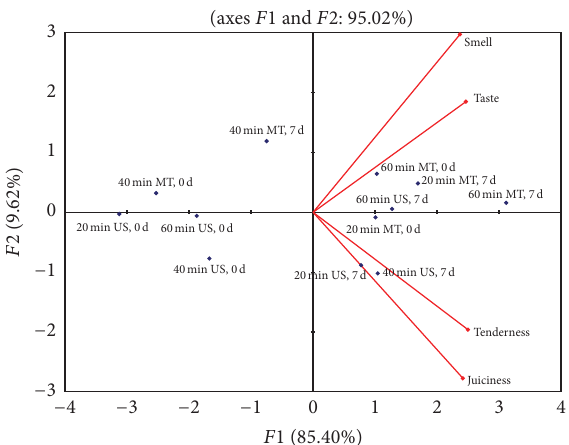
Figure 4: Sensory space of beef samples (longissimus dorsi) using two types of marination processes. MT, marinated traditionally; US, ultrasound; d, storage days at 4 ∘